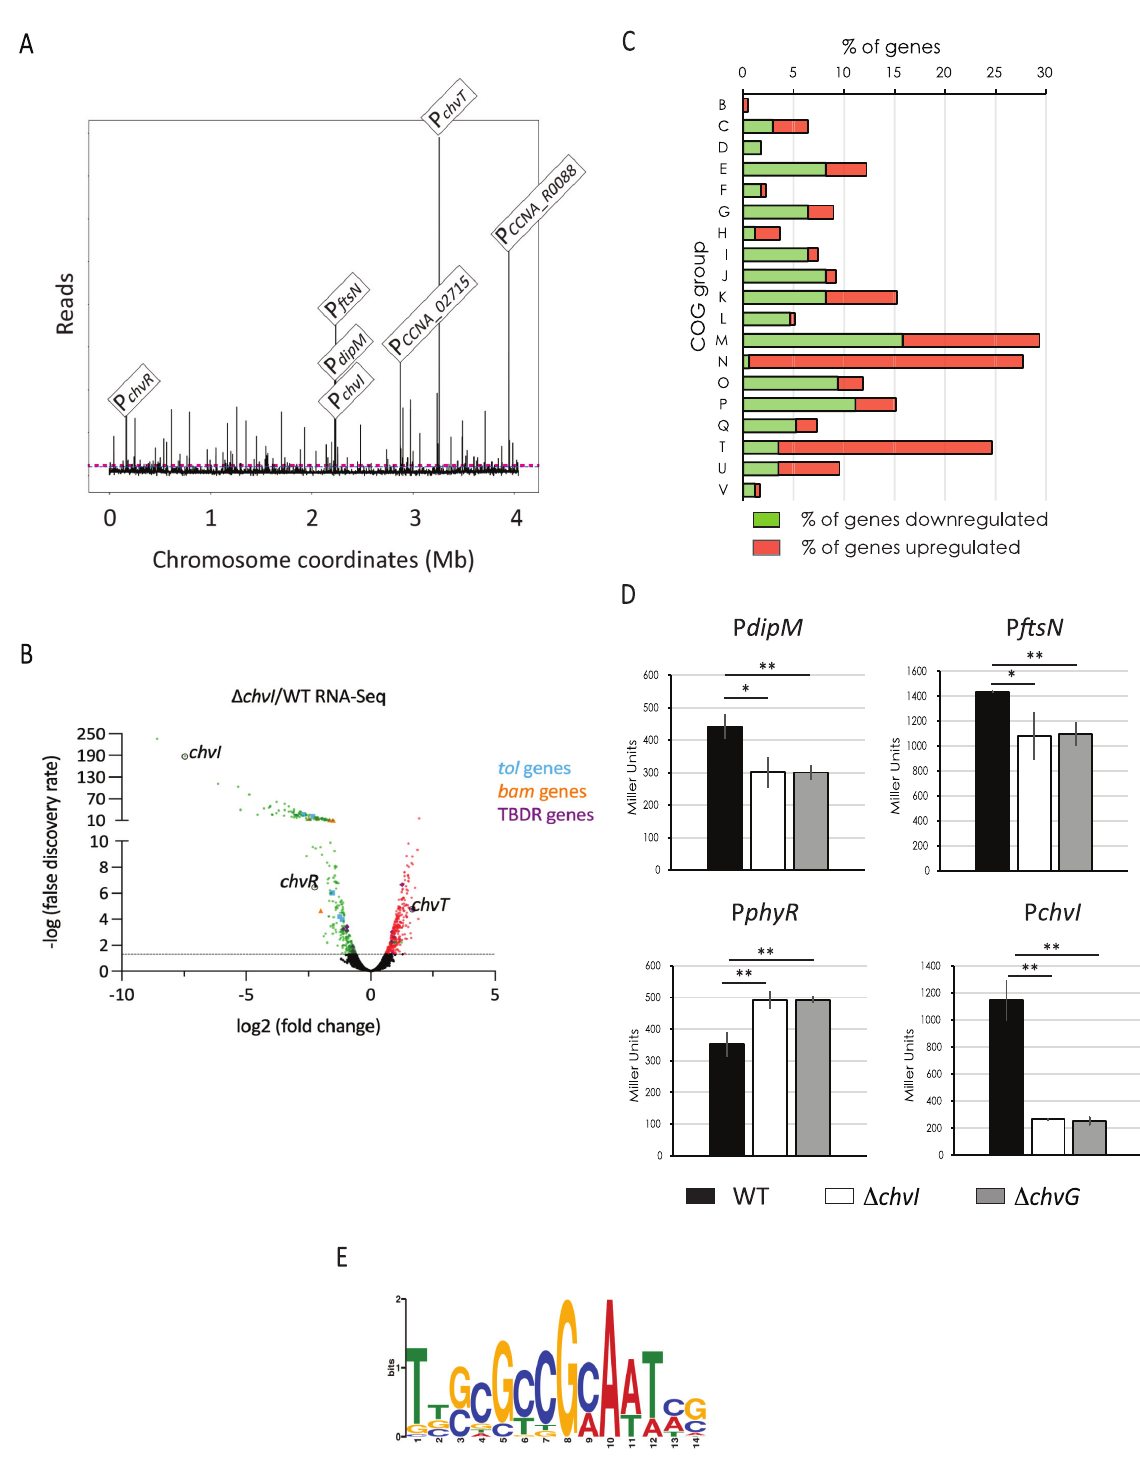
Fig 3. ChvI target genes determined by ChIP-seq and validated by β -galactosidase assays. (A) Genome-wide occupancy of ChvI on the chromosome of C . crescentus determined by ChIP-seq on WT strain grown in M2G. The x-axis represents the coordinates on the genome (Mb), the y-axis shows the normalized ChIP-Seq read abundance in reads. Some top hits, corresponding to the promoter regions of chvT , CCNA_R0088 , ftsN , CCNA_02715 , chvR , dipM and chvI operon, are highlighted. (B) Volcano plot representing the relation between the fold change and P values on gene expression between Δ chvI and WT strains exposed to osmotic upshift in PYE 6% sucrose by RNA-seq. Genes